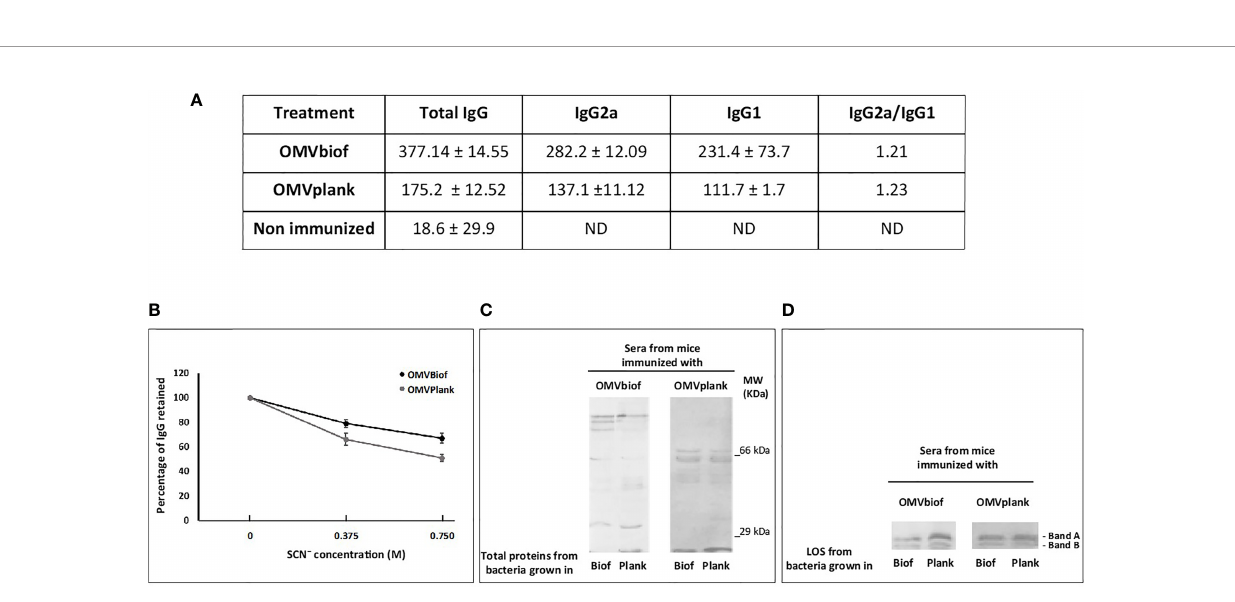
FIGURE 5 | Anti- B. pertussis antibodies induced by 2-dose vaccination schedules. (A) Anti- B. pertussis IgG titers as well as the IgG isotypes were measured 14 days after the second vaccination dose. The titers are expressed as the geometric mean of the data from each group. (B) The avidity of IgG antibodies was also measured 14 days after the second dose and is represented as percentages of eluted B . pertussis -speci fi c antibodies after treatment with increasing concentrations of ammonium thiocyanate (NH 4 SCN). The asterisk indicates statistically signi fi cant difference with p < 0.05. (C) Immunoblotting of total proteins of B . pertussis BpAR106 separated by 12.5% (w/v) SDS-PAGE and probed with the polyclonal antiserum obtained from immunized mice. The sera are designated according to the OMV-based vaccine used to immunize the mice. (D) Immunoblotting of BpAR106 LOS from both culture condition here tested separated by 12.5% (w/v) SDS-PAGE and probed with the polyclonal antiserum obtained from immunized mice. The sera are designated according to the OMV-based vaccine used to immunize the